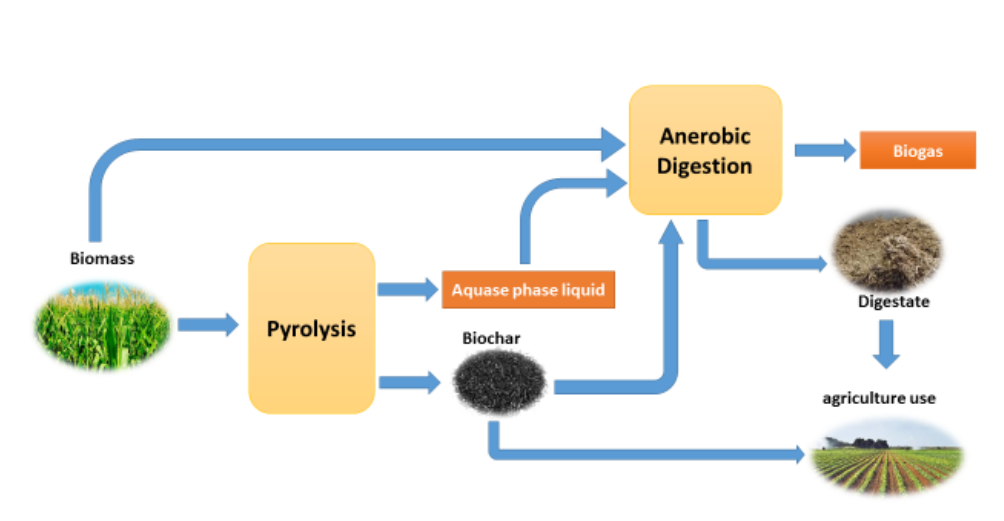
Figure 4. Coupling pathway for anaerobic digestion of APL derived from pyrolysis Anaerobic Digestion and hydrothermal carbonization Hydrothermal carbonization of